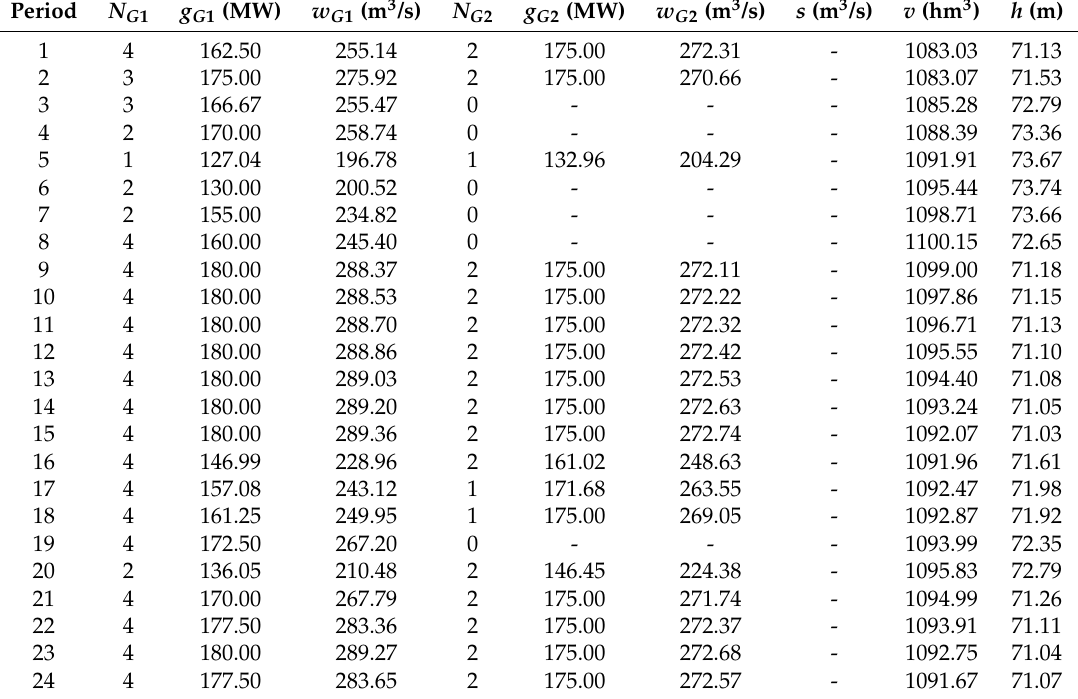
Table 6. Results with power losses-based objective function and null spillage upper bound-scenario